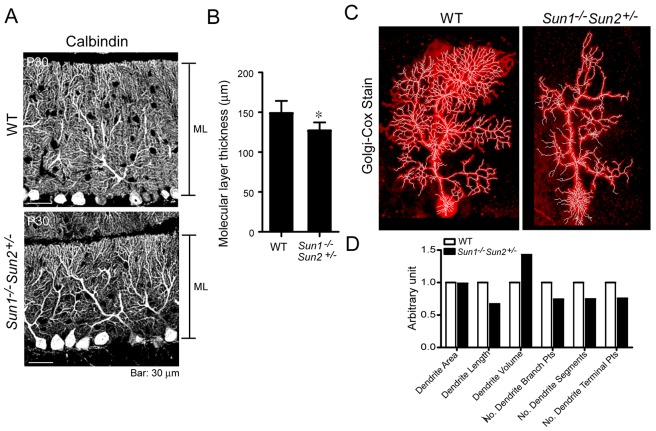
Mice deficient for Sun genes show retarded dendritic arborization. (A) Immunolabeling of P30 WT and Sun1−/−Sun2+/− Purkinje cell dendrites using an antibody against calbindin (gray). ML, molecular layer. (B) Thickness of the ML in the cerebellum of P30 WT and Sun1−/−Sun2+/− mice shown in A. The mean±s.e.m. was obtained from four mice of each genotype. *P<0.05, Student's t-test. (C) Golgi-Cox silver stain (red) of a WT (left panel) and a Sun1−/−Sun2+/− (right panel) Purkinje cell. The total dendritic area, length, volume, segments, branching points, segments and terminal points was analyzed using the Imaris 7.2 Filament Tracer function (white lines). The quantification of the data and statistics are shown in D. Scale bars: 30 μm.